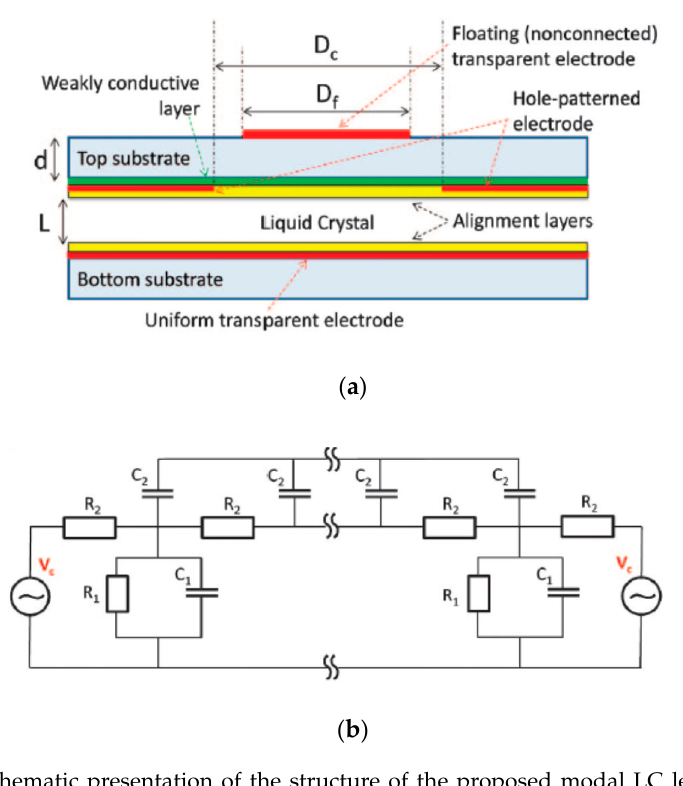
Figure 9. ( a ) Schematic presentation of the structure of the proposed modal LC lens, and ( b ) its approximate equivalent electrical circuit. V c is the control voltage (applied on the hole patterned electrode); R 1 and C 1 , are the equivalent electric resistance and capacitance of the LC cell, respectively; R 2 , is the equivalent resistance of the high-resistivity layer; C 2 , the equivalent capacitance due to the floating electrode. Reprinted with permission from [153]. Copyright 2016 Optical Society of America.